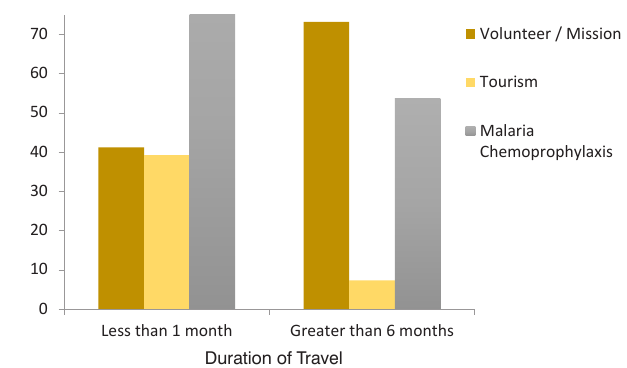
Figure 3. Purpose of Travel and Reported Malaria Chemoprophylaxis Compliance (%).